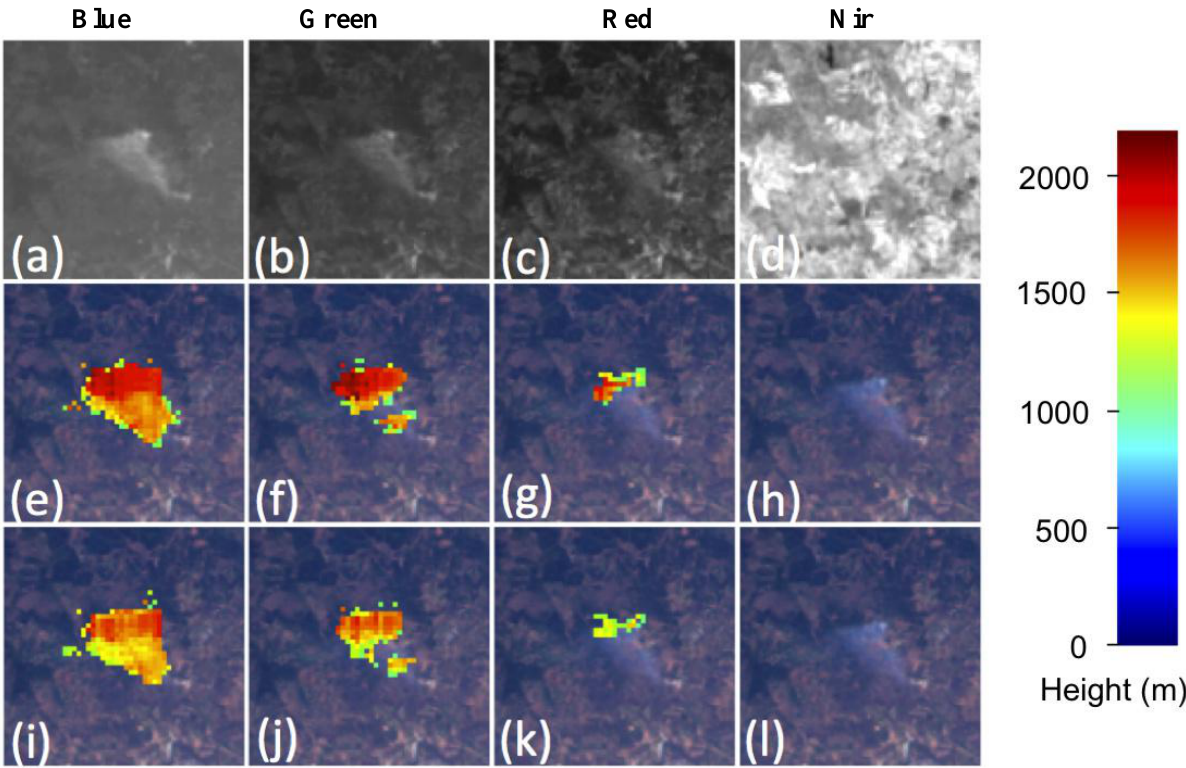
Figure 8. Single-band, local mode images and height retrieval maps for the scene in Figure 6. Aa camera local mode images for bands: ( a ) blue; ( b ) green; ( c ) red; and ( d ) NIR. Zero-wind heights for local mode data retrieved using bands: ( e ) blue; ( f ) green; ( g ) red; and ( h ) NIR. Wind-corrected heights corresponding to heights in (e–h): ( i ) blue; ( j ) green; ( k ) red; and ( l )